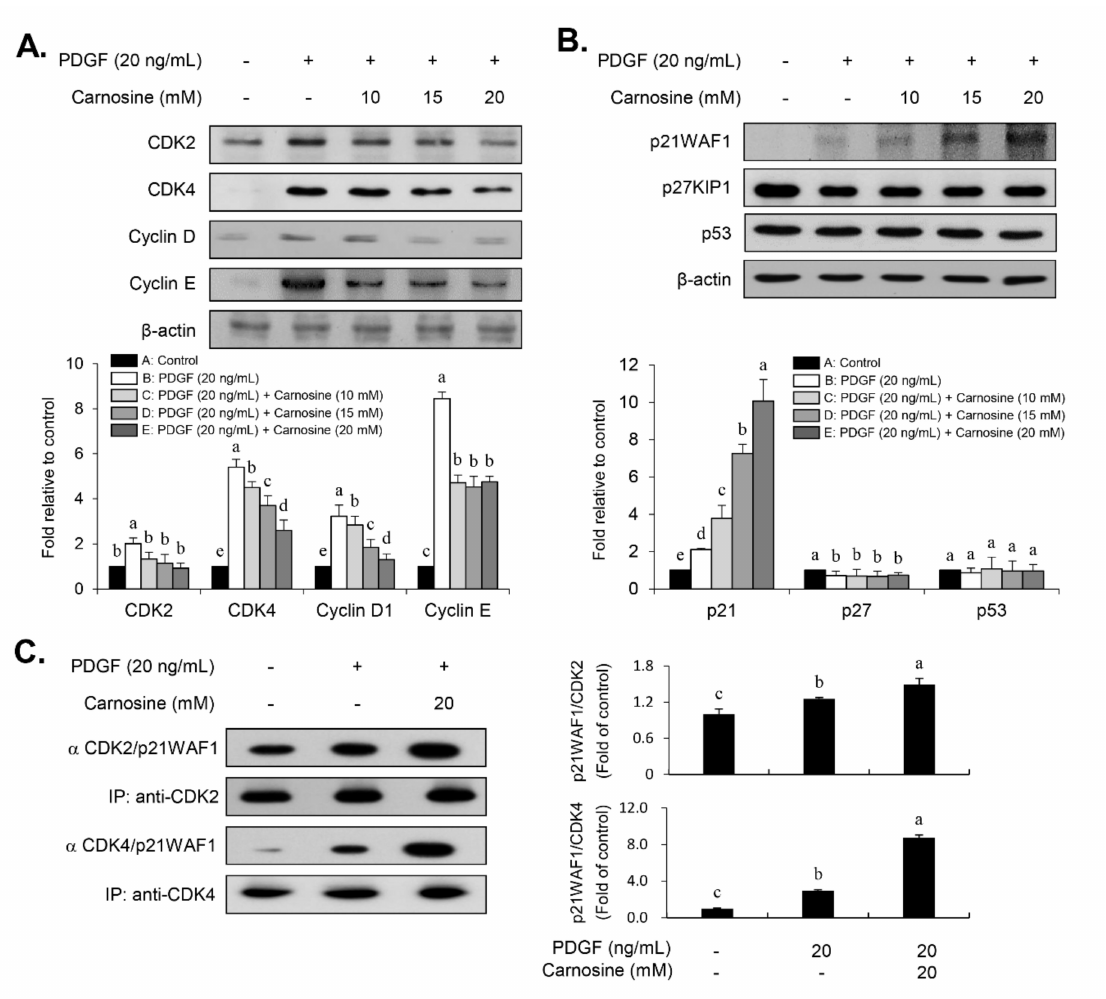
Figure 3. Carnosine repressed the expression levels of CDKs and cyclins and increased the expression level of p21WAF1 in PDGF-treated VSMCs. The cell lysates were analyzed by immunoblots with antibodiesspecificfor( A )CDK2, CDK4, cyclinD1, andcyclinEaswellas( B )p21WAF1, p27KIP1andp53. Actin was used as an internal control. ( C ) Cell lysates were immunoprecipitated with anti-CDK2 and anti-CDK4 antibodies, and then immunoblotted with anti-p21WAF1 antibody. All graphs exhibit the relative expression of the corresponding proteins on the blots. Values are expressed as mean ± SD values of three independent experiments. The di ff erent letters indicate significant di ff erences between the groups ( p <